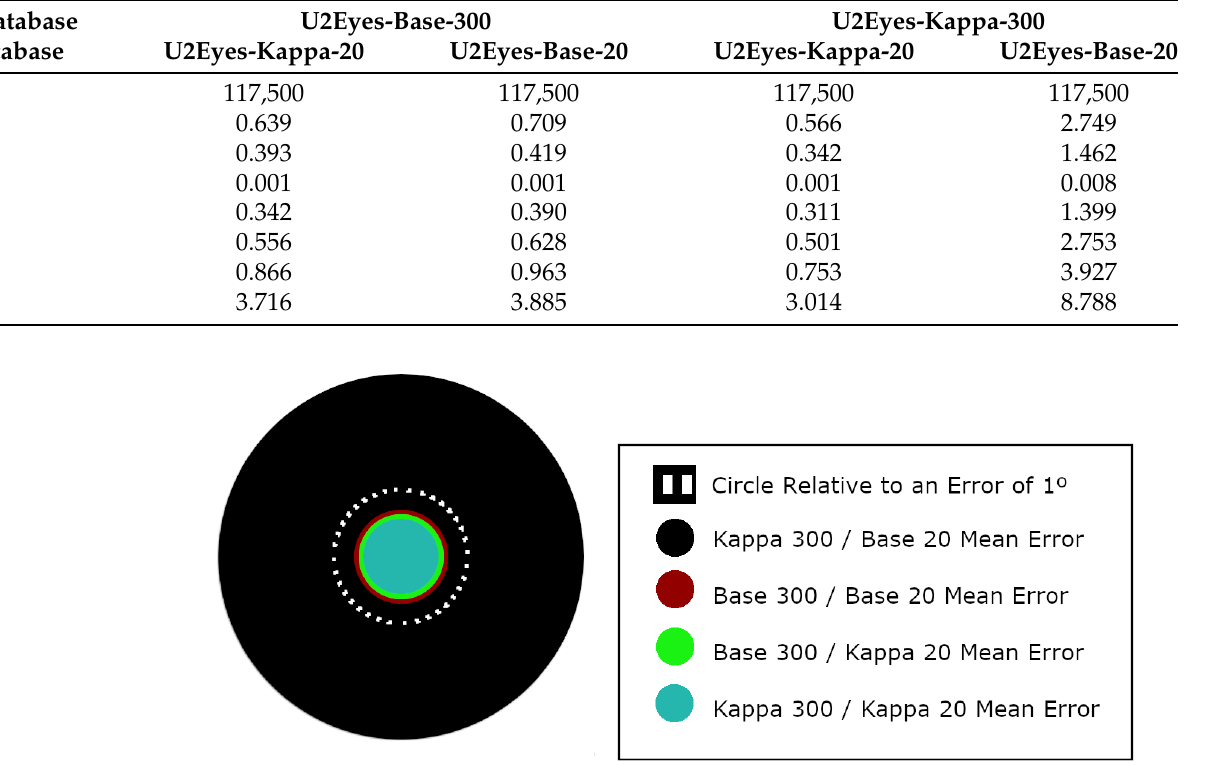
Table 4. Angular error (in degrees) of the gaze-estimation for the theoretical framework. The first row determines the dataset for which the model was trained (U2Eyes-Base-300 and U2Eyes-Kappa-300) and the second row the dataset used to test the trained model (U2Eyes-Base-20 and U2Eyes-Kappa-20).